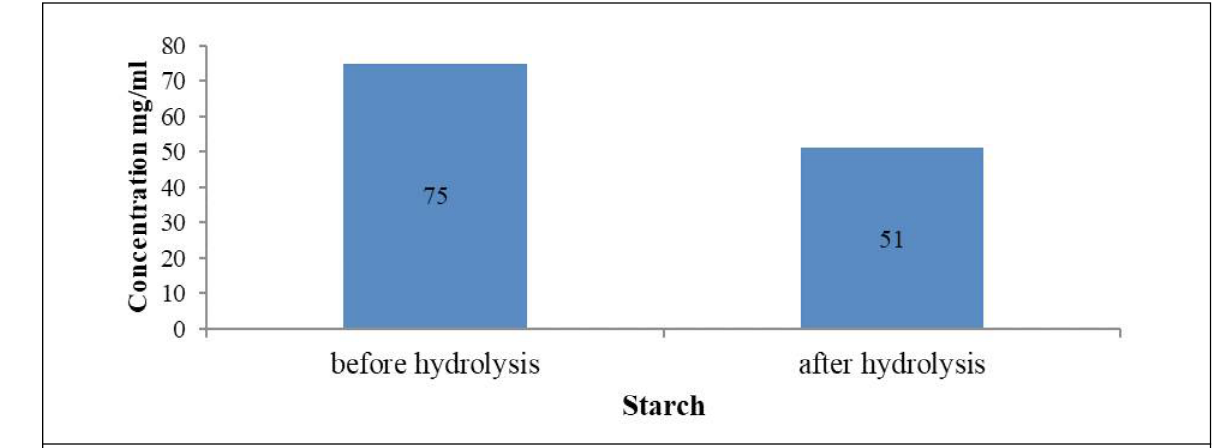
Figure 2: Amorphophallus commutatus tuber